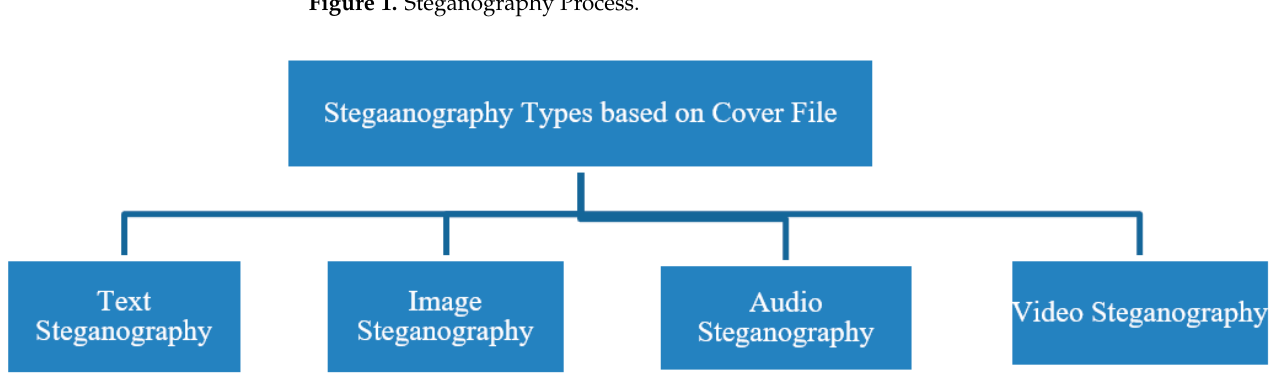
Figure 1. Steganography Process.